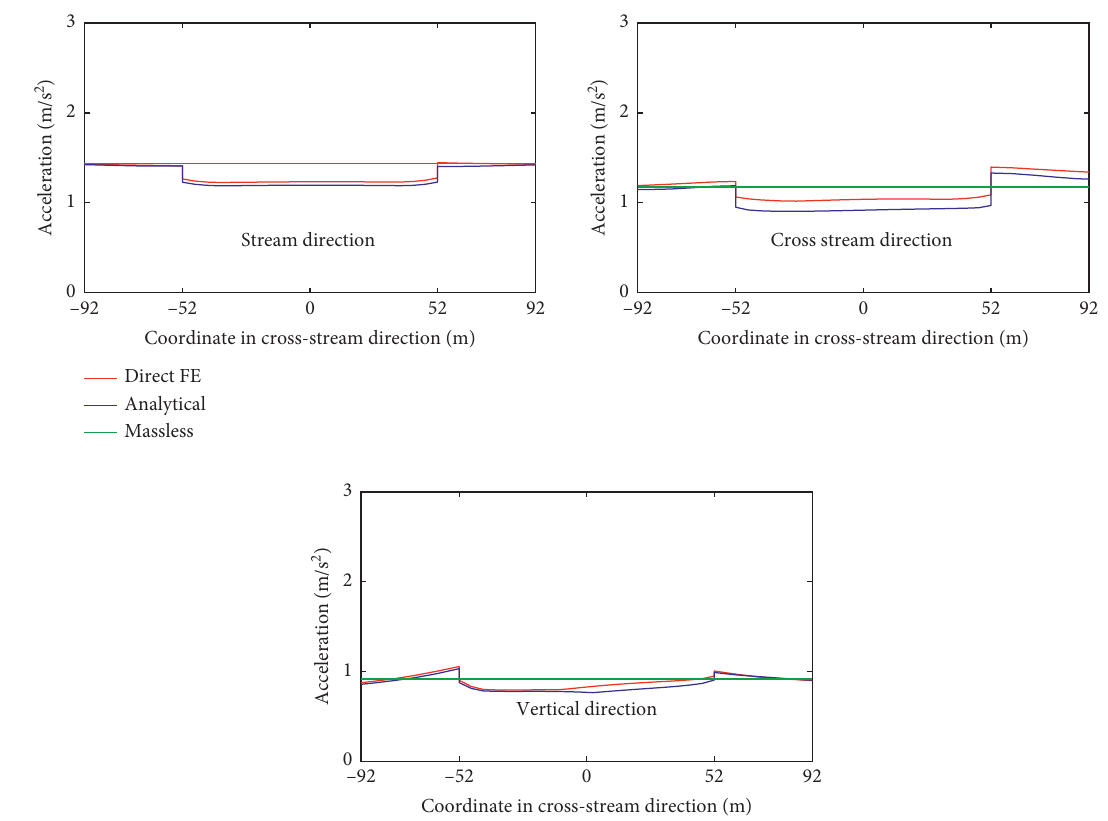
Figure 10: Distribution of PGA recorded at points along the canyon free surface induced by the Taft earthquake in the (a) stream, (b) cross- stream, and (c) vertical directions for free-field modelling of the rock foundation with the direct FE method, analytical method, and massless